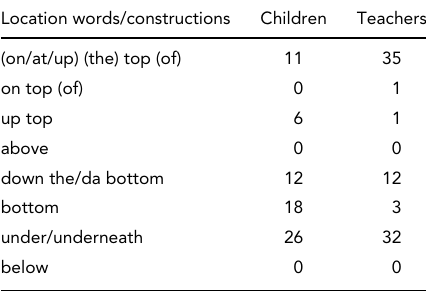
Uses of Location Words by Children and Teachers Location